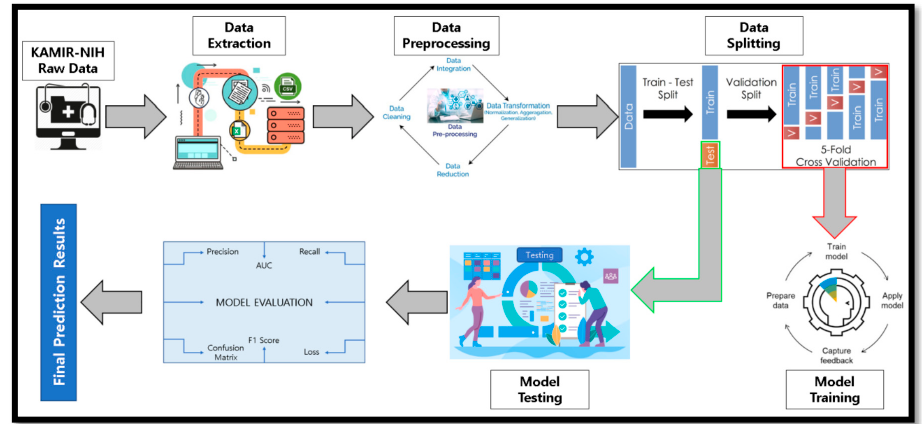
Figure 2. Overall workflow of proposed predictive modeling system.